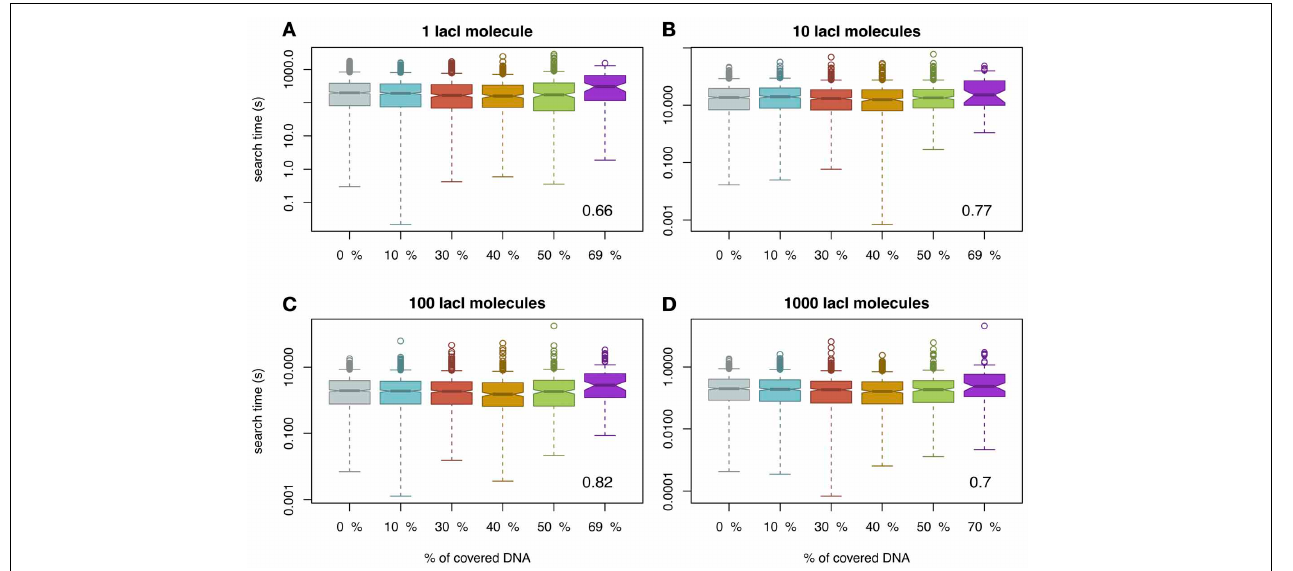
FIGURE 2 | The average time for the TF to reach the target site (measured in seconds) as a function of DNA crowding in the case of immobile obstacles. For each set of parameters, we performed 1000 simulations. Note that the amount of covered DNA is higher than in the case of mobile obstacles, due to the fact that the molecules spend more time bound to the DNA. It should be noted that in the case of 70% of the DNA being covered by DNA binding proteins, the probability to locate the target